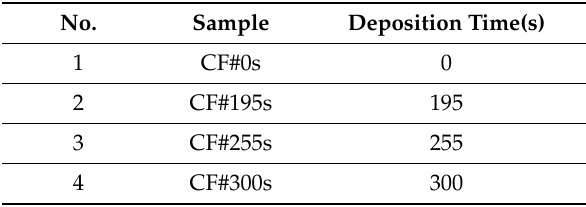
Table 1. Deposition times for different samples.